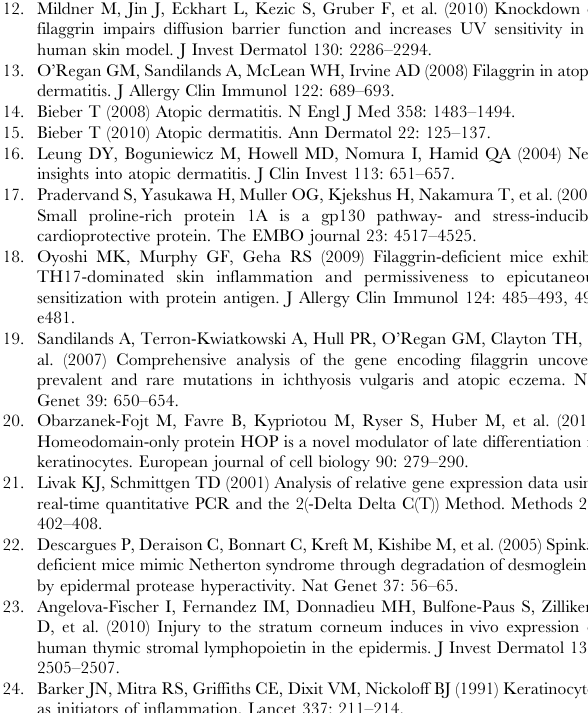
Figure S1 Corneodesmosomal components expression in unchanged between WT and a/a ma ft/ma ft/J